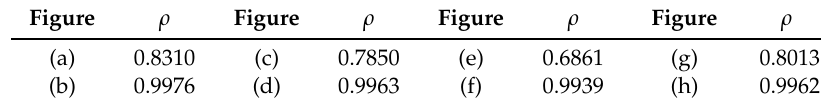
Figure 15. Height difference profiles for baseline lengths: ( a ) 400 m; ( b ) 400.0375 m; ( c ) 400.075 m; ( d ) 400.15 m.